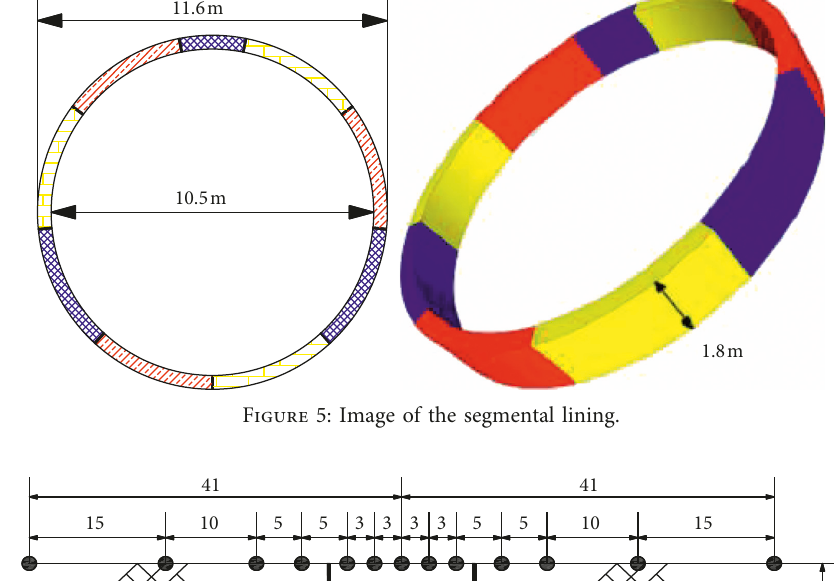
Figure 5: Image of the segmental lining.